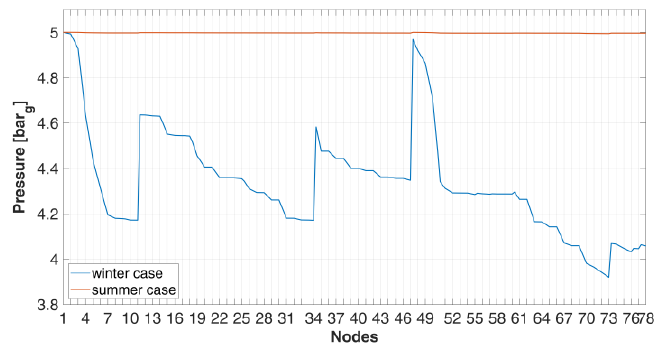
Figure 5. Comparison between the nodal pressure sequence of the winter base case (no injection) and the summer base case (no injection).